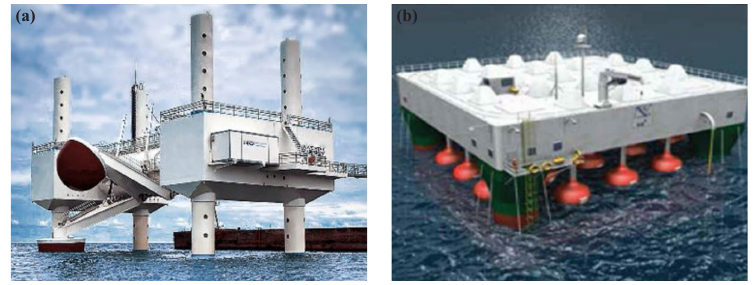
Figure 9. The WaveStar device [127] and the FO3 device [128] are shown as typical examples of multi-point absorbers in ( a , b ),